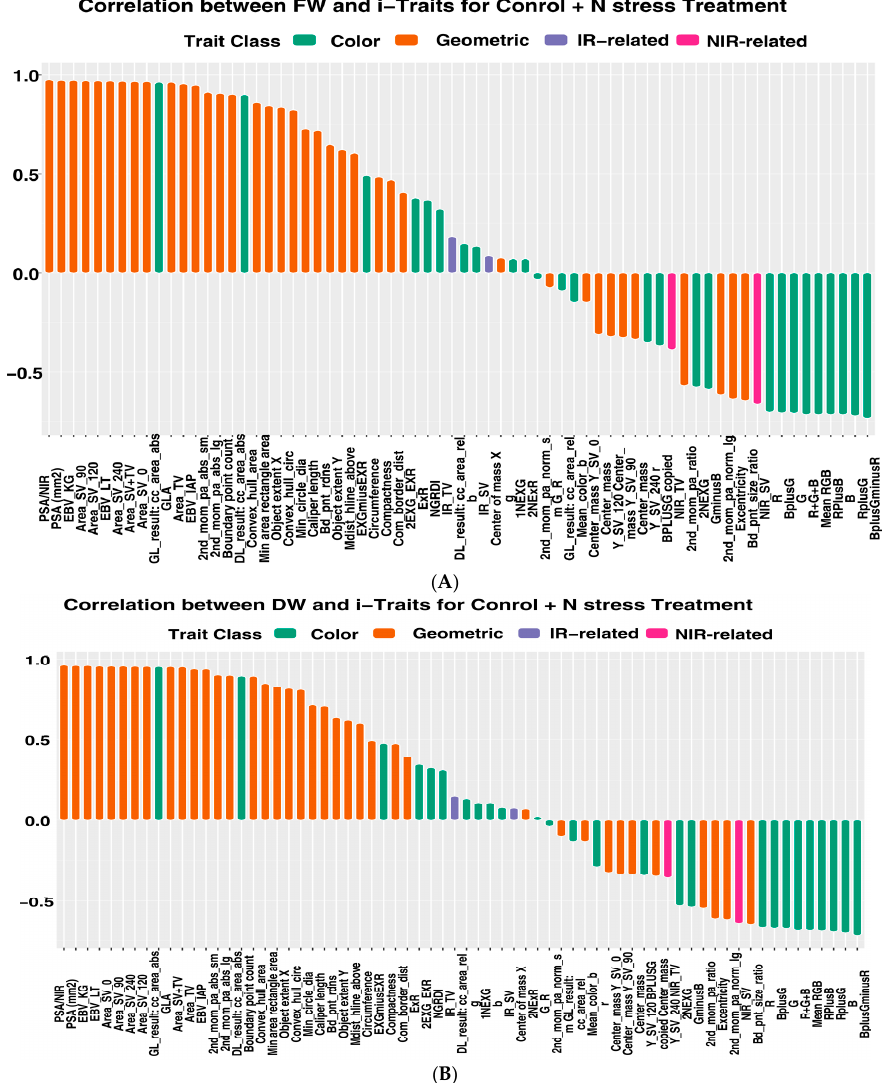
Figure 4. Pearson correlation coefficient was estimated to study the relationship between image- derived traits and response variables FW ( A ), and DW, ( B ), control + N stress treatment are displayed in a cluster column chart.